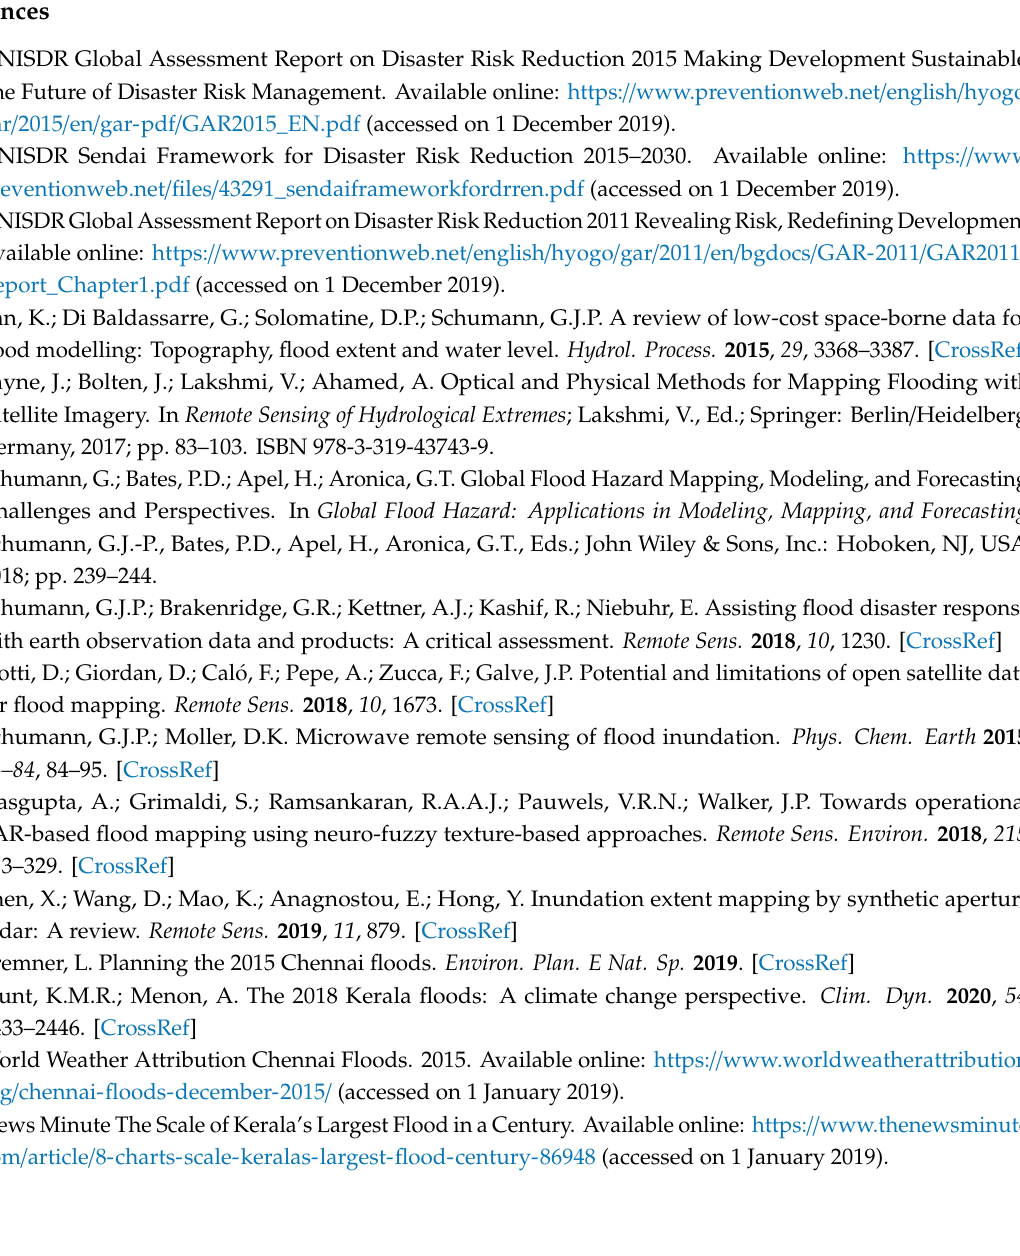
Table S1: Details of the CYGNSS SNR dataset used along with observed flood extent considered in this study; Table S2: Details of the Sentinel—1 SAR imagery used in this